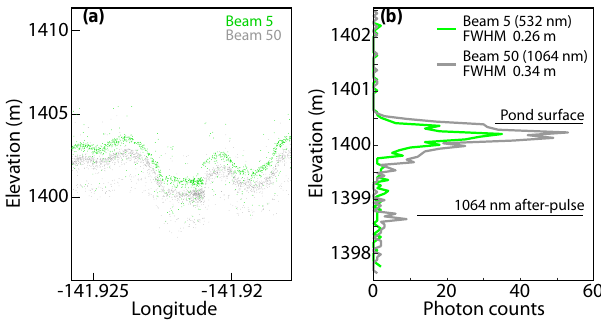
Figure 7. Surface return and histogram of the signal return for MA- BEL beams 5 (532nm) and 50 (1064nm) over the ∼ 70m melt pond in Fig. 6. (a) MABEL signal photons over for beams 5 and 50 for the 70m melt pond in Fig. 6. The 1064nm beam shows evidence of a secondary return 1.5m below the main signal return, due to un- intended secondary pulses from the MABEL laser that occur under some operational conditions. (b) Plotted for each beam are surface- return photon counts per 0.01m vertical bins against elevation (m). The elevations of beams 5 and 50 are calibrated to one another. The full width at half maximum (FWHM) for each histogram is indi- cated in the legend. The secondary return <1m below the main signal return, which is more evident in the 1064nm beam, is due to unintended secondary pulses from the MABEL laser that occur under some operational conditions; this was removed for FWHM